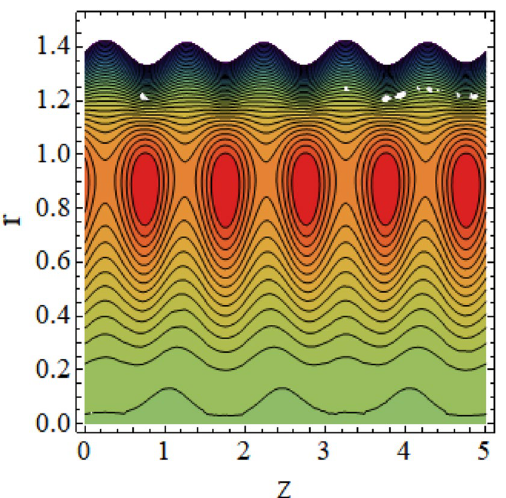
Figure 13. Streamlines for Q = 0.6 with (cid:31) 1 = 0.4, φ = 0.037, a = 0.01, z d 1 = 0.5, z d 2 = 2, z d 3 = 3.5, h 1 = 0.5, h 2 = 2, h 3 = 3.5.